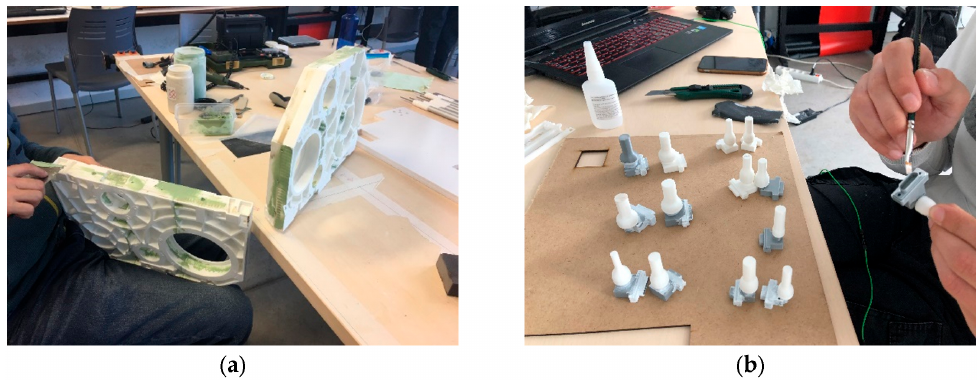
Figure 11. ( a ) Process of joining two elements. ( b ) Process of matching color.